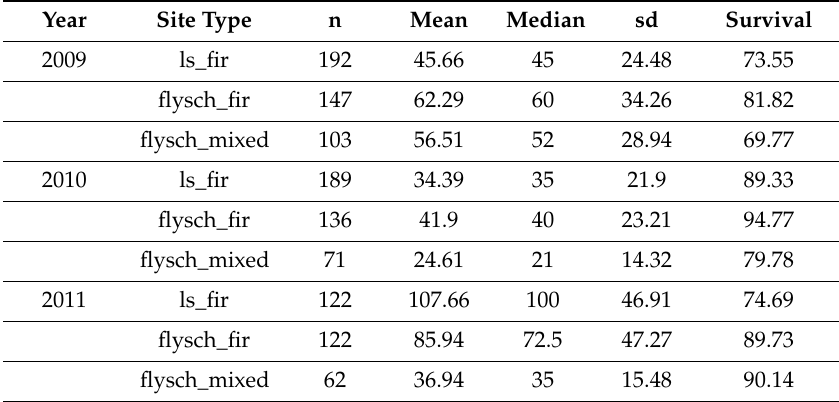
Table 4. Annual growth (mm) and survival (%) of all seedlings. 2012 growth values are by definition identical to those in Table 1. Survival rate (%) in 2012 was 88.00, 91.24, 80.00 for ls_fir, flysch_fir and flysch_mixed respectively.